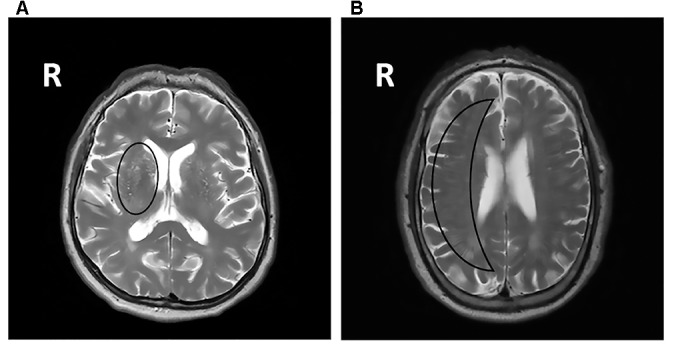
T2-weighted brain MRI scans showing symmetric extensive PVS at the level of the basal ganglia (A) and in the centrum semiovale (B). PVS, perivascular spaces; R, right.